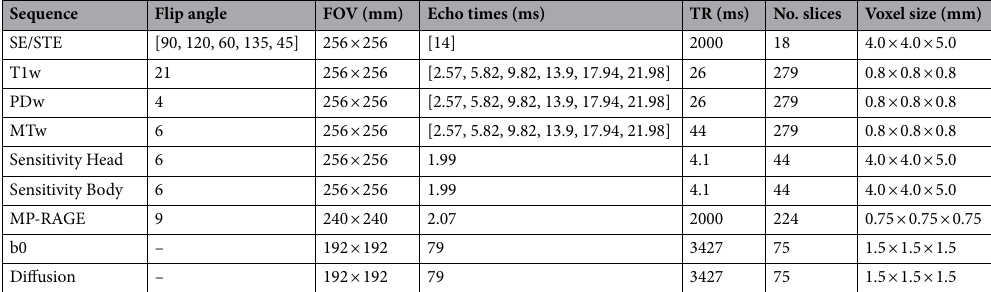
Table 5. Magnetic Resonance Imaging sequence parameters in the order of acquisition. SE/STE spin-echo/ stimulated echo imaging, T1w T1-weighted, PDw proton density-weighted, MTw magnetization transfer- weighted, MP-RAGE magnetization-prepared